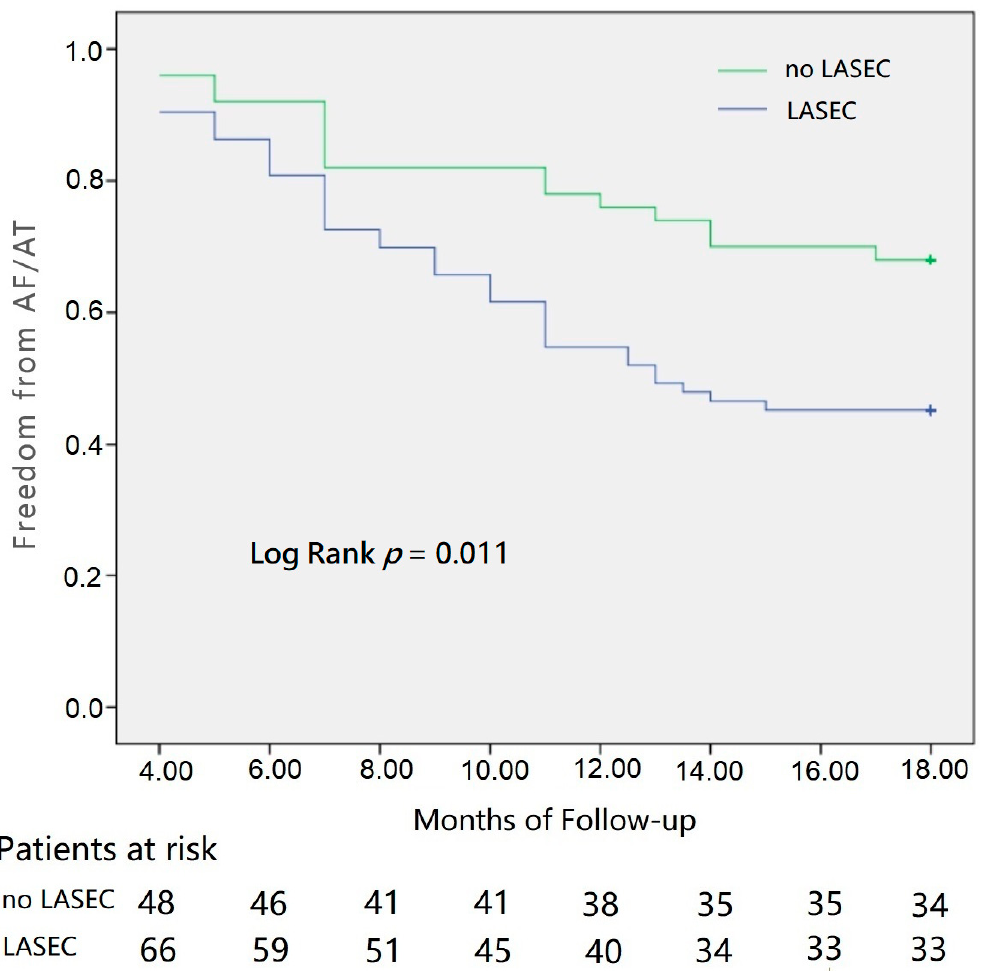
Figure 3. Considering a blanking period of 3 months, AF/AT recurrence in the LASEC and no LASEC groups was 54.8% (40 patients) and 32% (16 patients), respectively, at 18-month follow-up. The difference in LASEC had produced significant variations in AF/AT recurrence-free survival between the two groups. Table 4. Univariate and multivariate Cox regression analysis of freedom from AF/AT recur- rence-free survival (time to AF/AT recurrence is the dependent variable).